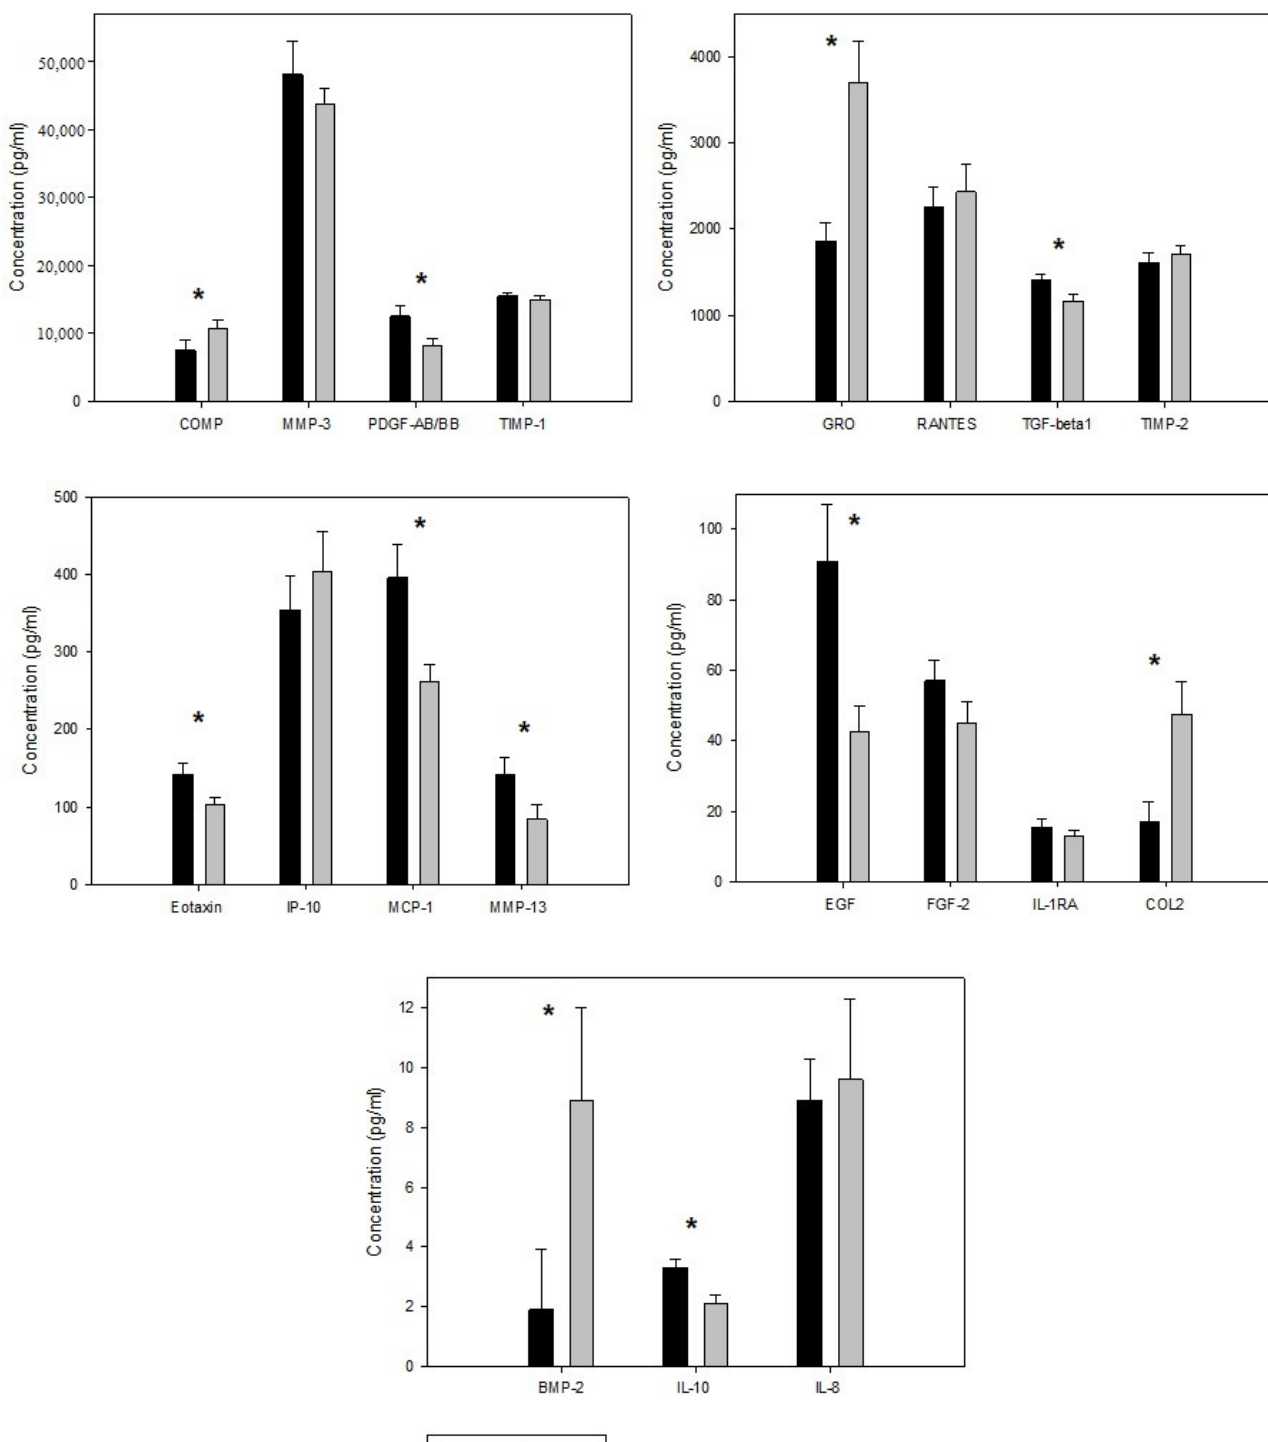
Figure 1. Mean concentration of biomarkers before and 3 months after the treatment with PRP. Error bars indicate standard deviation; differences were analyzed using Student’s t -test; * p < 0.05.